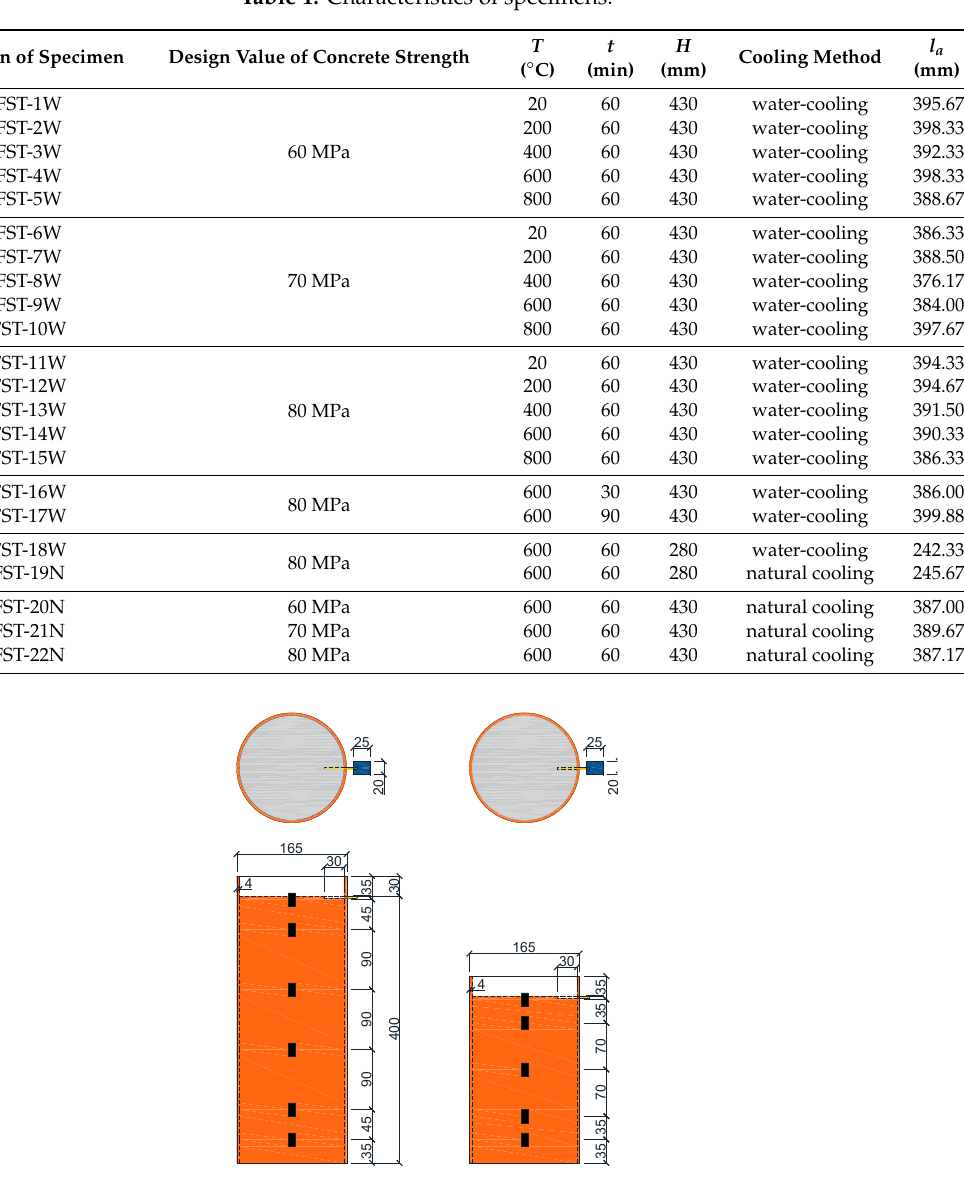
Figure 1. Section size and strain gauges distribution of specimens (mm). Table 2. Concrete proportions.